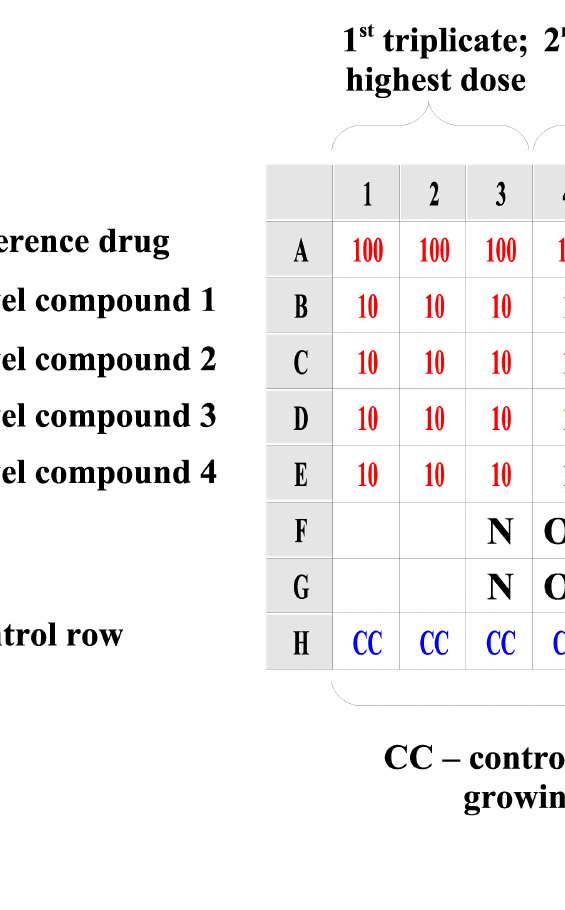
Figure 1. Example test plate designed to be processed in Cheburator. The sample plate with 1 control row (H), 1 row for the reference drug (A), and 4 rows for 4 novel studied compounds (B, C, D, and E, respectively) tested in 4 concentrations. Please note that not all rows have to be used on the plate, and different ranges of concentrations for different compounds can be applied in the test. Concentrations are highlighted in red. Control of untreated cells (CC) and control of media (CM) are in blue and green, respectively.